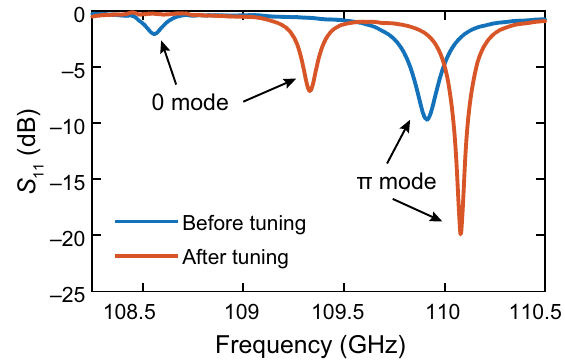
FIG. 12. The measured reflection S 11 before and after tuning. The 0 mode and π mode are indicated. The 0 mode was intentionally tuned by a larger degree than the π mode in order to achieve better field balance for acceleration and